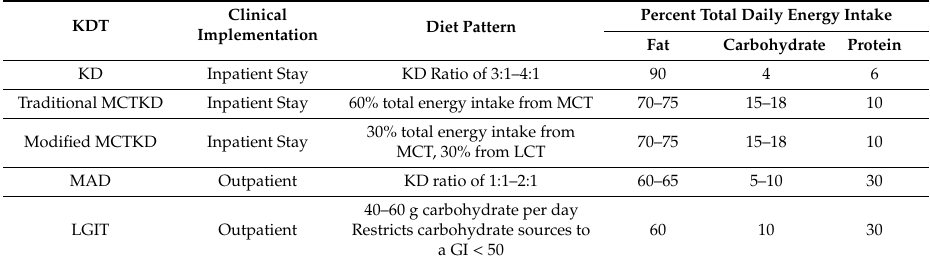
Table 1. Macronutrient Distributions across